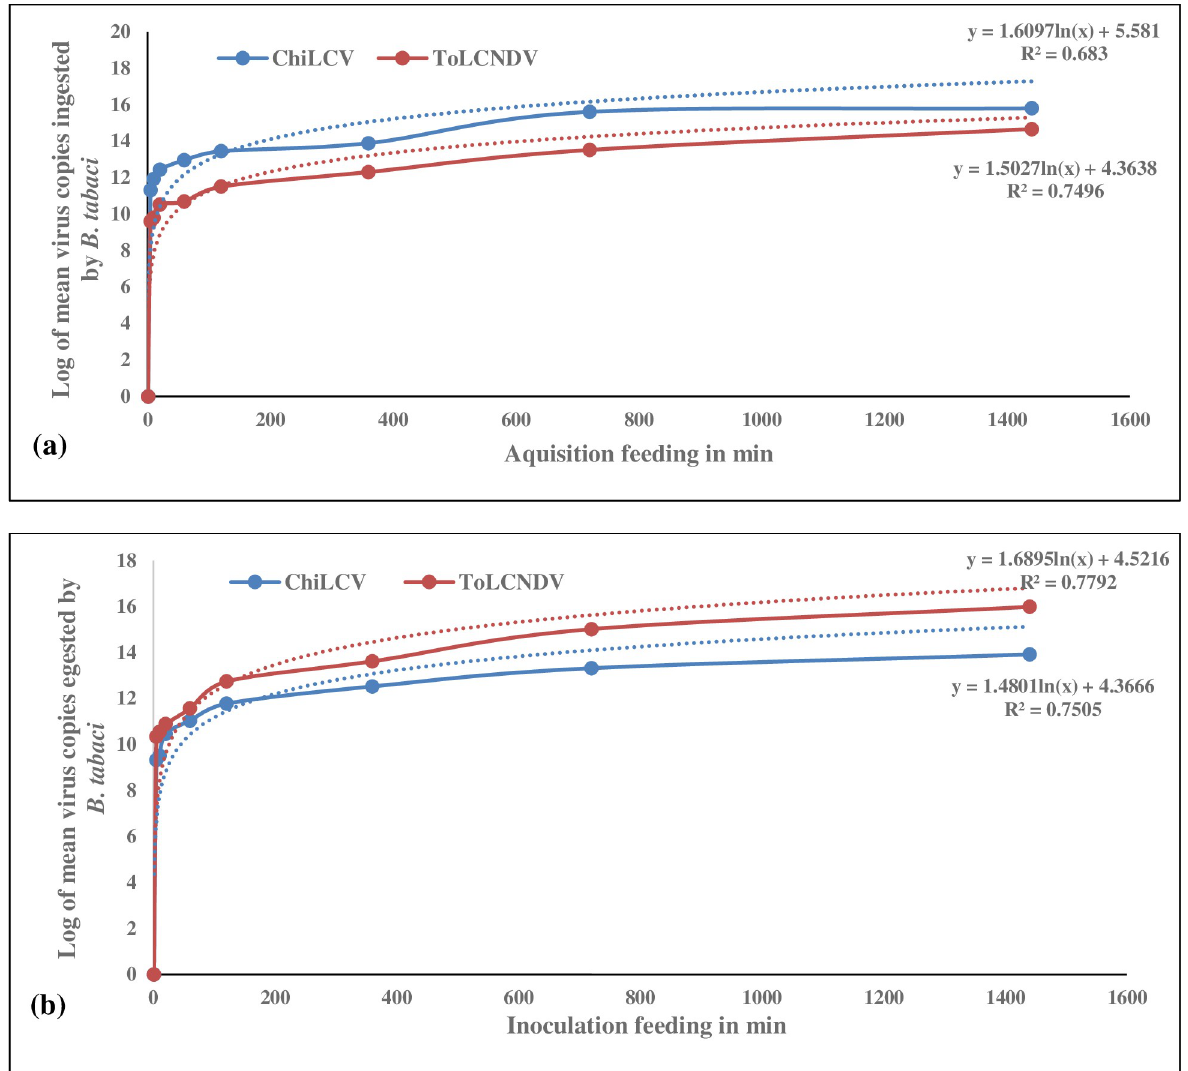
Fig 2. Dynamics of ToLCNDV and ChiLCV copies ingested (a) and egested (b) by individual B . tabaci . Feeding exposure is expressed in min on X- axis and log of virus copy number is plotted on Y-axis. ToLCNDV and ChiLCV copies were estimated at 1 min, 5 min, 10 min, 20 min, 1 hr, 2 hrs, 6 hrs, 12 hrs, and 24 hrs of feeding. The increase in virus copies is marked by maroon (ToLCNDV) and blue (ChiLCV) lines. The dotted lines indicate a best-fit logarithmic curved line to illustrate predicted increase of virus copies with time. R 2 values and equations are mentioned on the graph. ssDNA viruses transmitted by B . tabaci in a persistent circulative way. B . tabaci ingests the begomovirus particles during feeding on phloem sap of infected plants. Virions pass through the food canal and enter the digestive tract. Midgut, especially the filter chamber is the site for begomovirus translocation. Virions are transported through the cytoplasm of filter chamber in vesicles that fuse with basal plasma membrane and released in the hemocoel. The interaction of begomovirus with B . tabaci has been the subject of many studies for the last fifty years [33]. During the entire process, the viral proteins need to interact with several midgut and primary salivary gland proteins [34]. Coat protein (CP) of the begomovirus interacts with the various insect tissues to ensure further translocation within B . tabaci until egestion. Several proteins in the midgut are known to bind with the begomovirus CP and influence the transmission. Heat